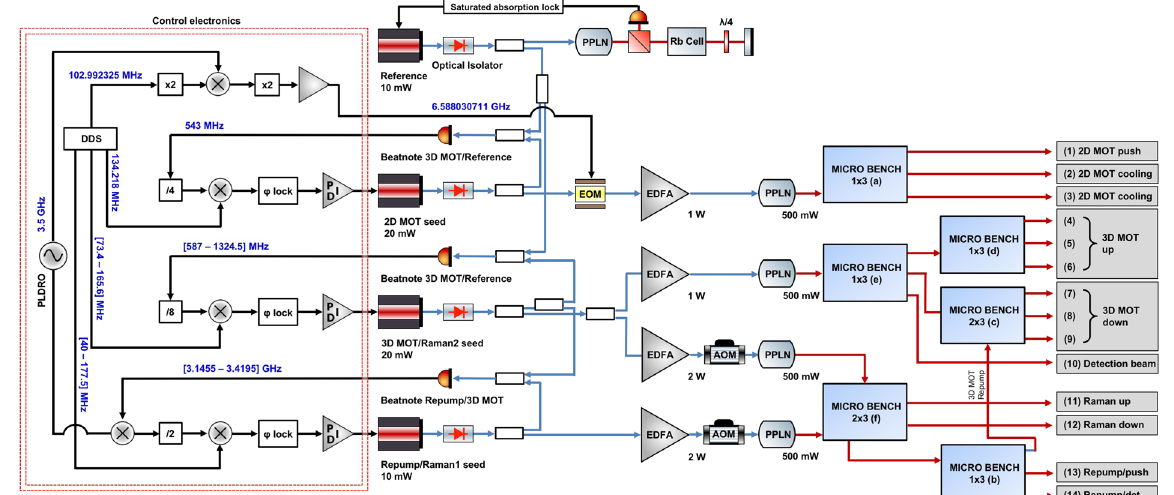
Figure 2. Schematic of the laser system. Each primary oscillator passes light through a fibered optical isolator and into a combination of fused fiber splitter/combiners to create beatnotes. The three primary oscillators that are frequency stabilized via beatnotes seed four EDFAs, which in turn seed four PPLN crystals. The Raman outputs are controlled using fibered AOMs at 1560 nm, after the amplifiers but before the PPLN crystals. After the PPLN crystals, the light is sent to various micro-optic modules to split, combine, and output the light via PM optical fibers. AOMs contained within the 1 × 3 micro-optic bench, (e) in Fig. 3, provide control of the 3D MOT fibers. To create a frequency reference for the RF control of the laser system, we employ a PLDRO to generate a 3.5 GHz signal for mixing with the high frequency beatnote in the system - the beat between 3D MOT/Raman 2 and Repump/Raman 1; we exert control over the Repump/Raman 1 laser via mixing with a DDS. A part of the power of the PLDRO is mixed with a DDS control frequency and doubled to drive the EOM in the 2D MOT chain that addresses the repump transition. The other beat notes are controlled similarly but do not require a high frequency reference like the PLDRO - we divide down the various beatnotes and mix directly with DDS signals. The PLDRO and DDS are phase locked to a 100 MHz input signal. RF and microwave connections are in black, 1560 nm PM fibers are in blue, and 780 nm PM fibers are in